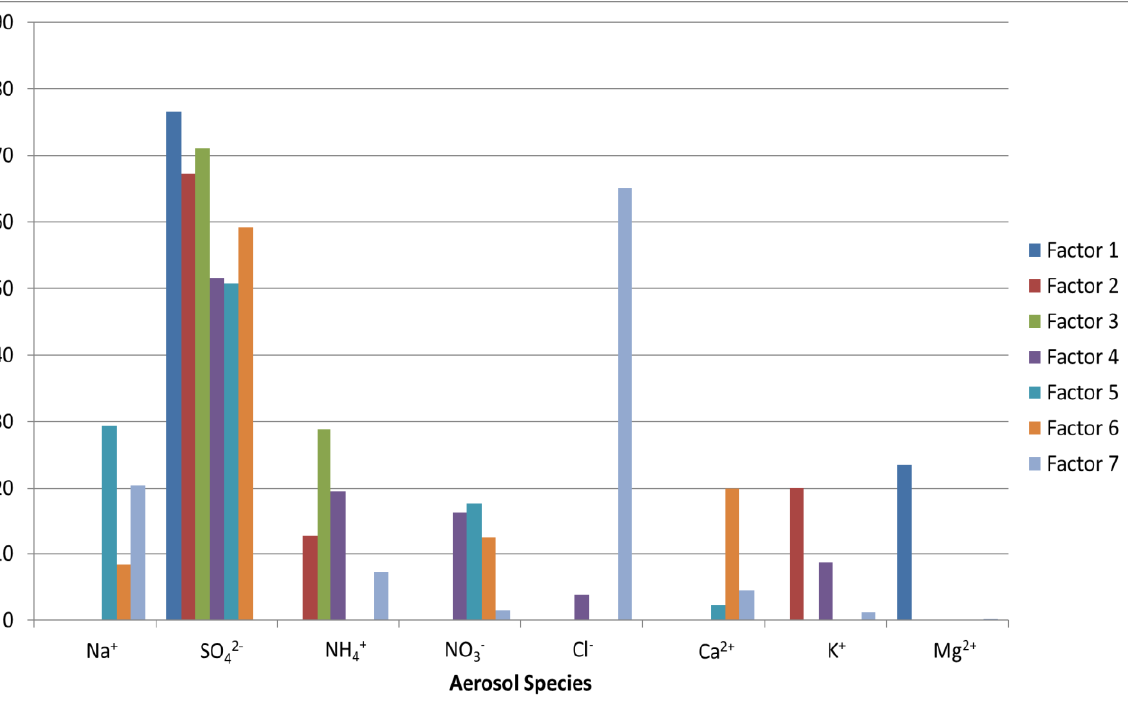
Figure 9. Seasonal variation of factor profile of aerosol species and their fractional contribution in different aerosol samples. Major dominant factors are factors 1, 2 and 3, which have been identified as sulfate-rich, sea salt and dust-dominated, respectively (see text for details).